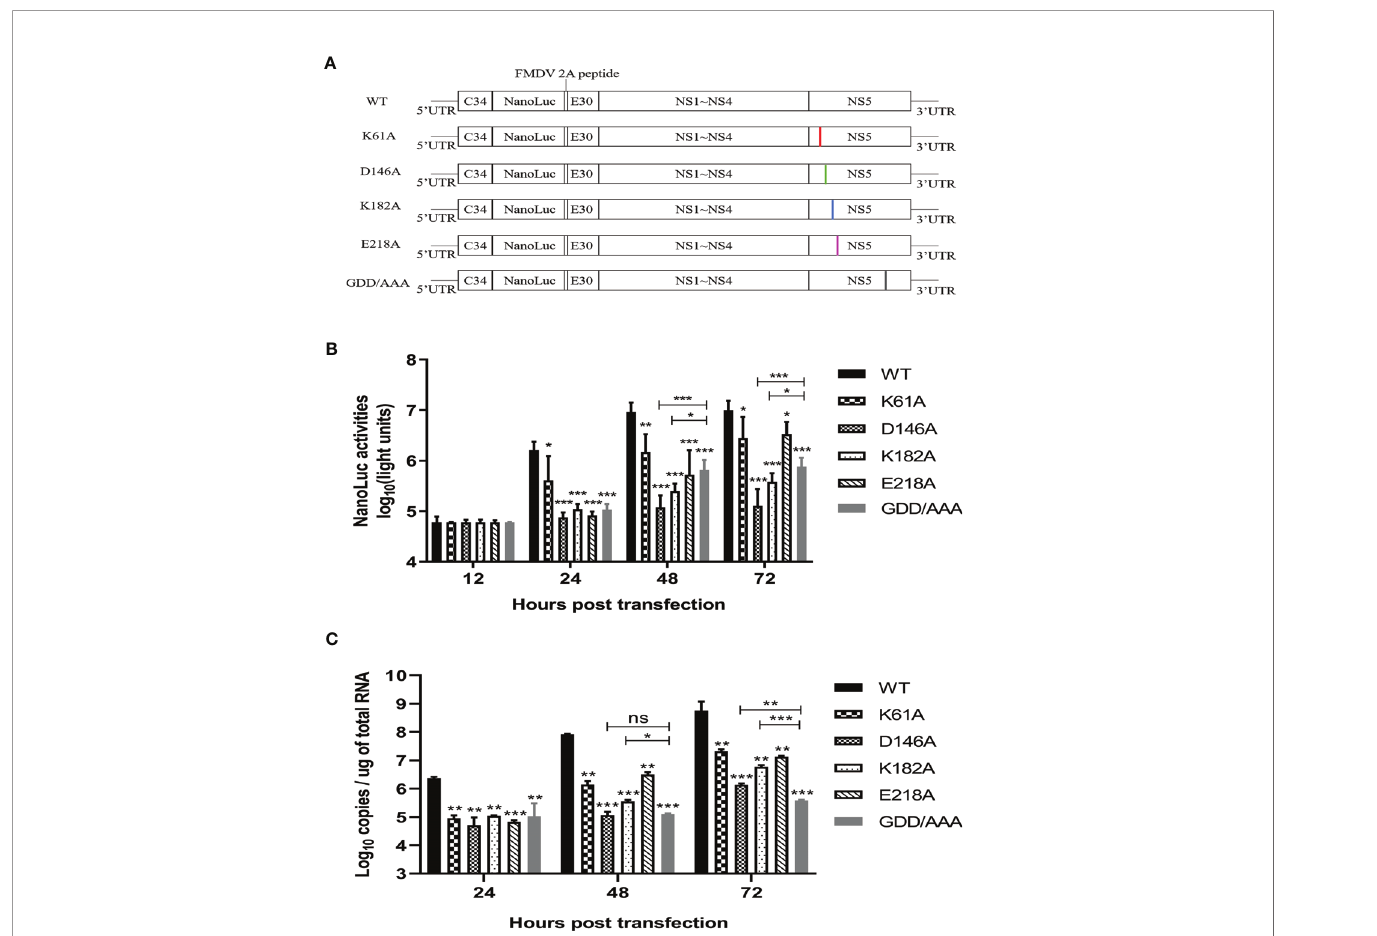
Figure 4A . Replication was monitored by Nano-Glo luciferase (NLuc) activity encoded by TMUV replicon. After transfection of BHK-21 cells with equal amounts of replicons, the K61A, D146A, K182A, and E218A mutant replicons produced lower levels of NLuc activity than WT replicon at 24, 48 and 72 h post- transfection, showing a level-dependent reduction in N-7 methylation ( Figure 4B ). A parallel experiment was